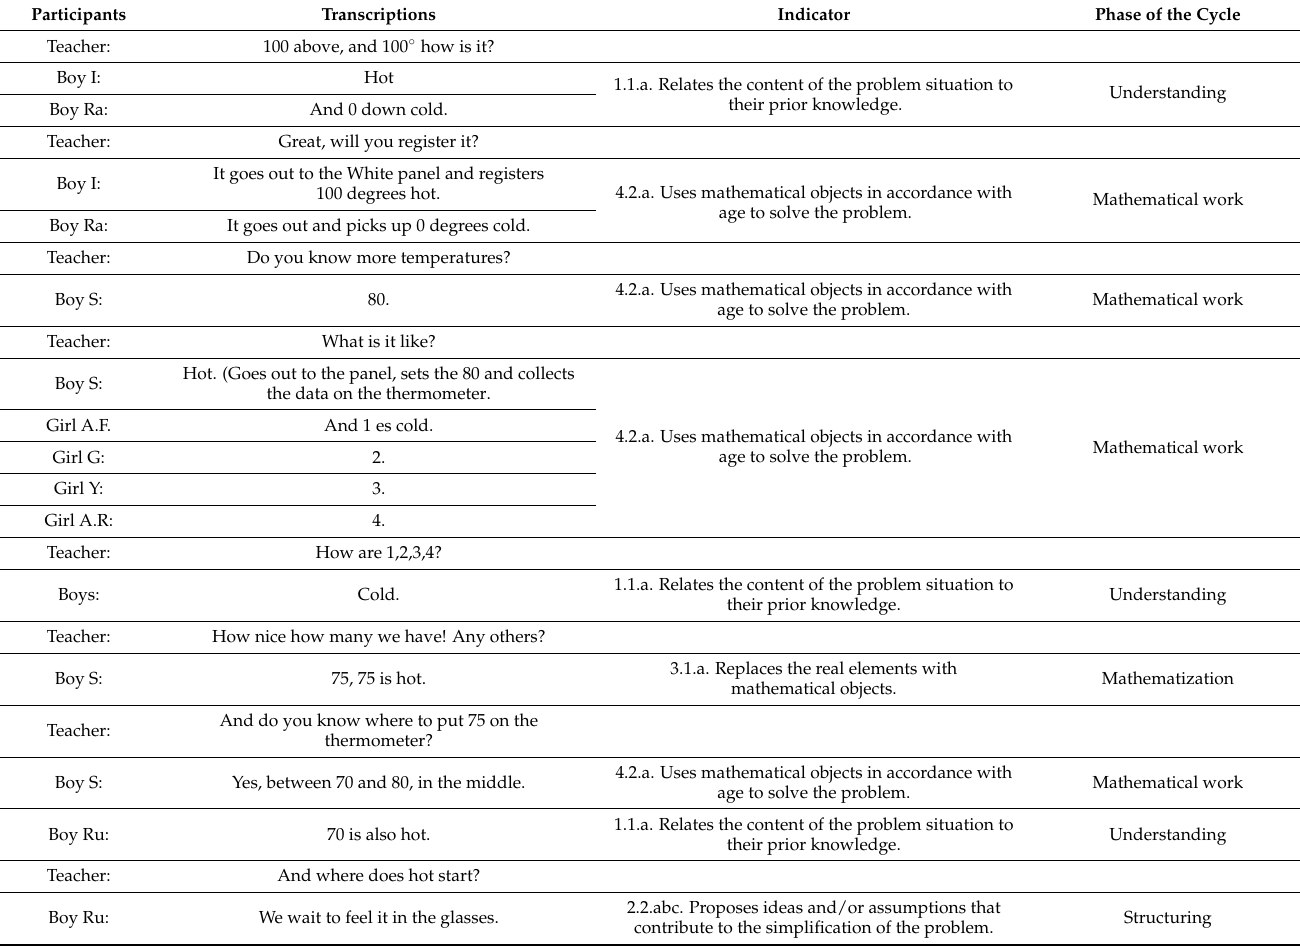
Table 9. Extract from the analysis of the modelling activity in early childhood education with the REPMM instrument.